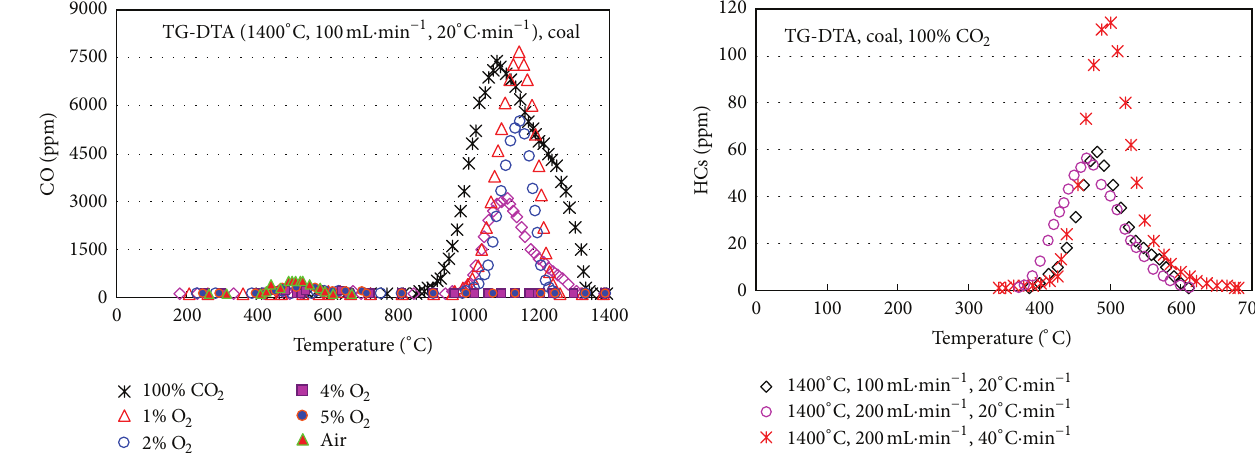
Figure 24: HCs gas generation of coal with different temperature gradients and gas flow rates.